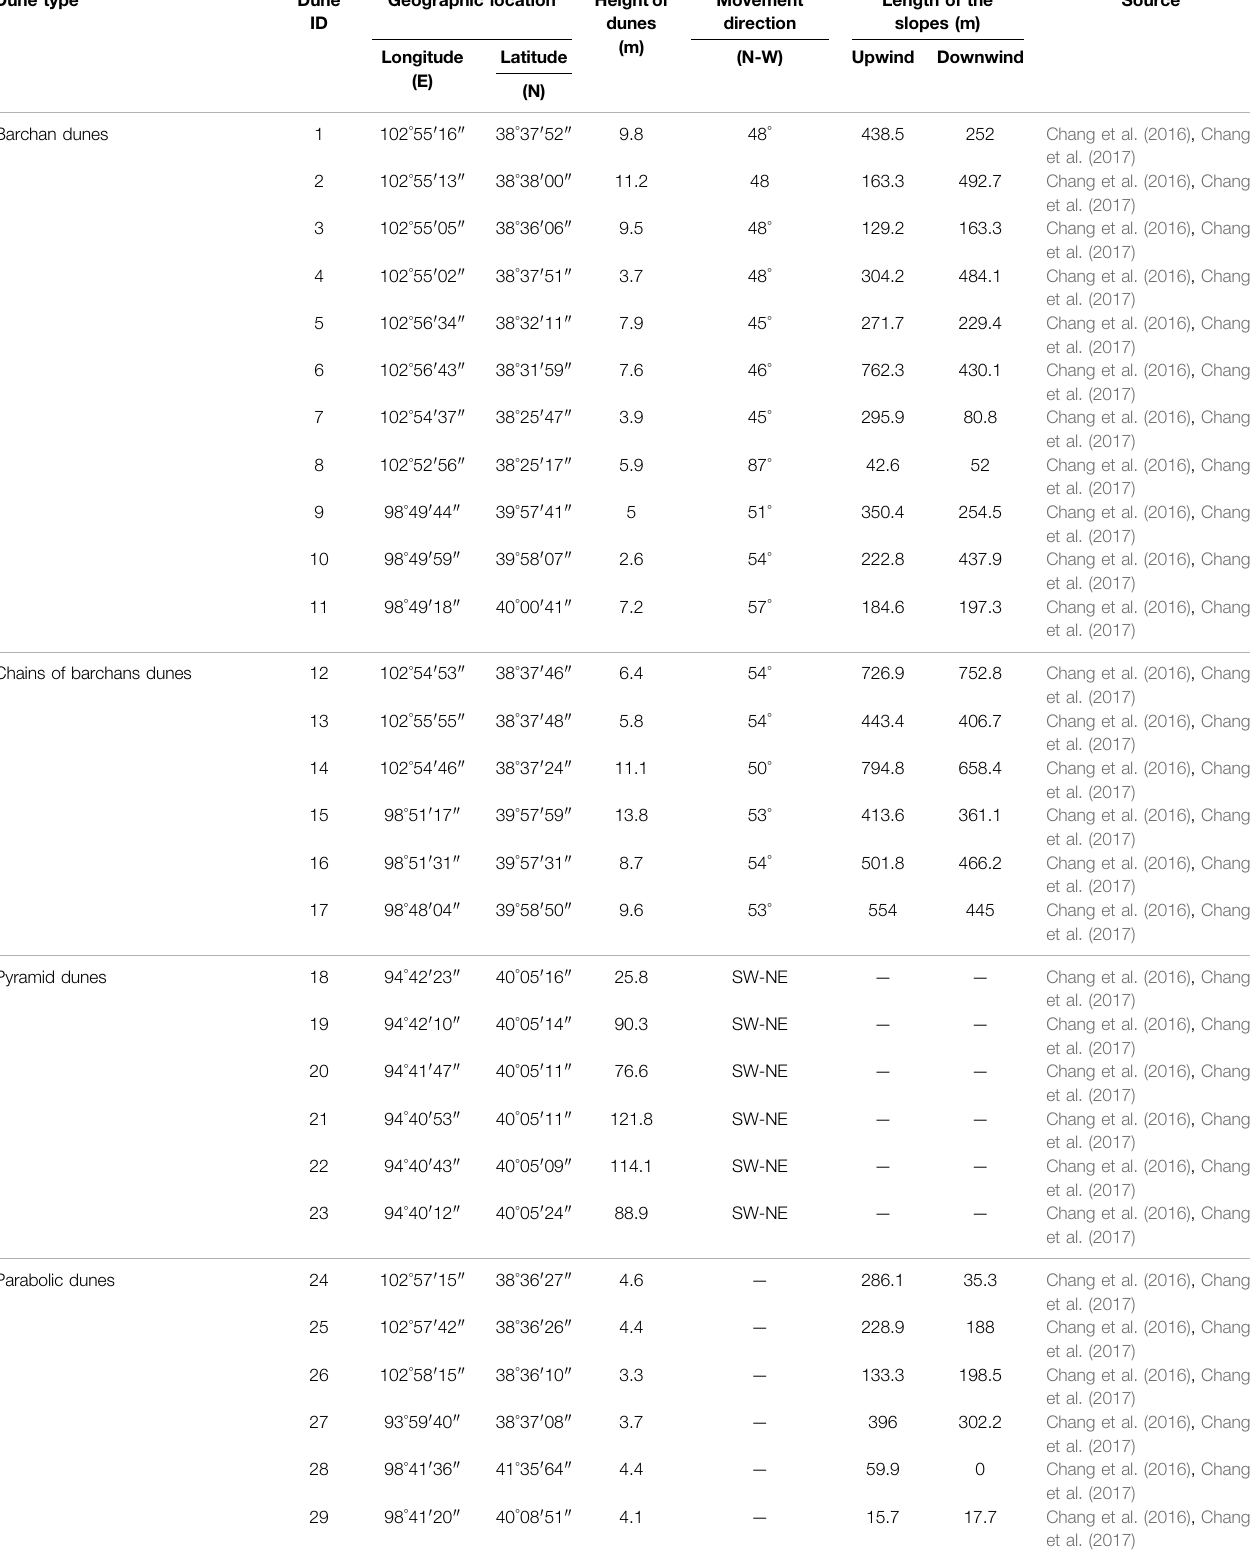
TABLE 1 | The locations, heights, movement directions, and lengths of dunes in the Hexi Corridor. Dune type